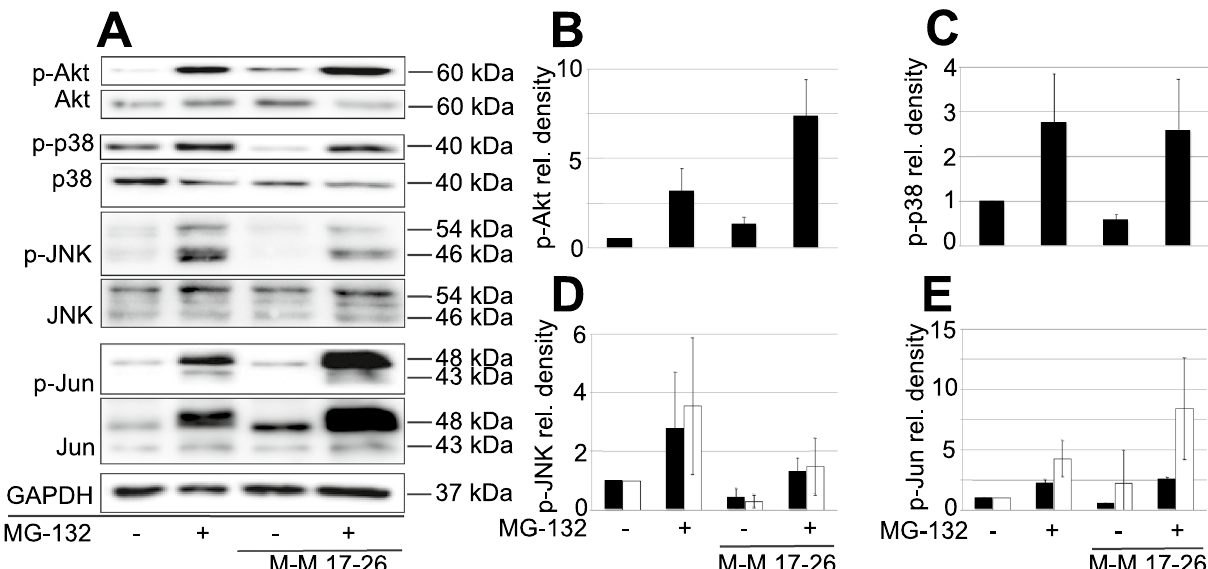
Figure 5. MG-132-induced phosphorylation of the previously examined cell signaling molecules in wild type and dominant negative H-Ras-expressing (M-M17-26) PC12 cell mutants. ( A ) Western blot analysis of Akt, p38, JNK and c-Jun phosphorylation in wild type and M-M17-26 PC12 cells. Cells were treated for 3 h with MG-132 (2.5 µM). All blots were cropped, original membrane images are shown in Suppl. Figure 4. Diagrams show the activation of Akt ( B ), p38 ( C ), JNK ( D ) and c-Jun ( E ) with or without MG-132 treatment. Bars represent the mean ratio ± SD values calculated from data of three independent